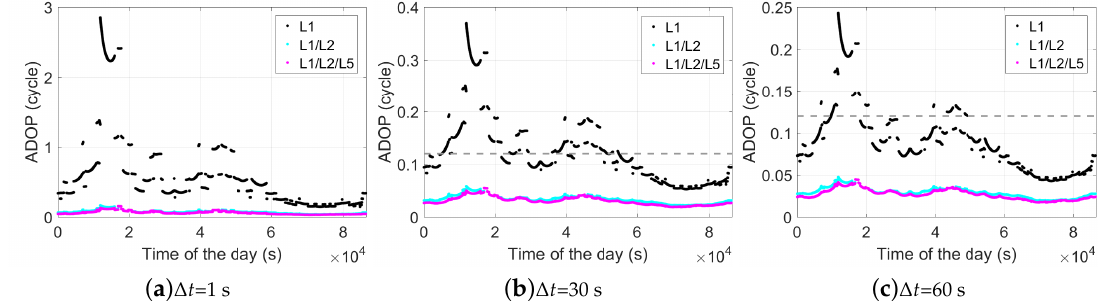
Figure 4. Ambiguity dilution of precision (ADOP) of baseline CUAA-CUBB in the phase-only two-epoch case. The time span between the two epochs is 1 ( a ), 30 ( b ), and 60 s ( c ). The gray dahsed lines mark the ADOPs of 0.12 cycles. Note that the sub-figures have different scales